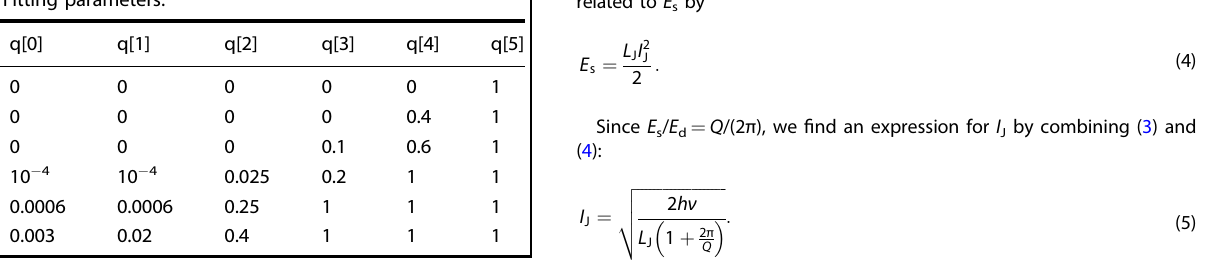
Fig. 3 The switching probability of the SPC (blue dots with error bars computed as standard errors) versus the normalised power of the signal for different bias currents I from 16 to 12 nA, corresponding to detection of 1 – 5 photons, respectively. The fi tting red curves are plotted against the middle x -axis “ mean photon number ” . The lower x -axis is the power in Watts, obtained from the PAT steps (the correspondence between the normalised power and the power in Watts is given in Methods). A green dashed line is given to guide eyes, indicating the beginning of the dark count fl Table 1. Fitting parameters.